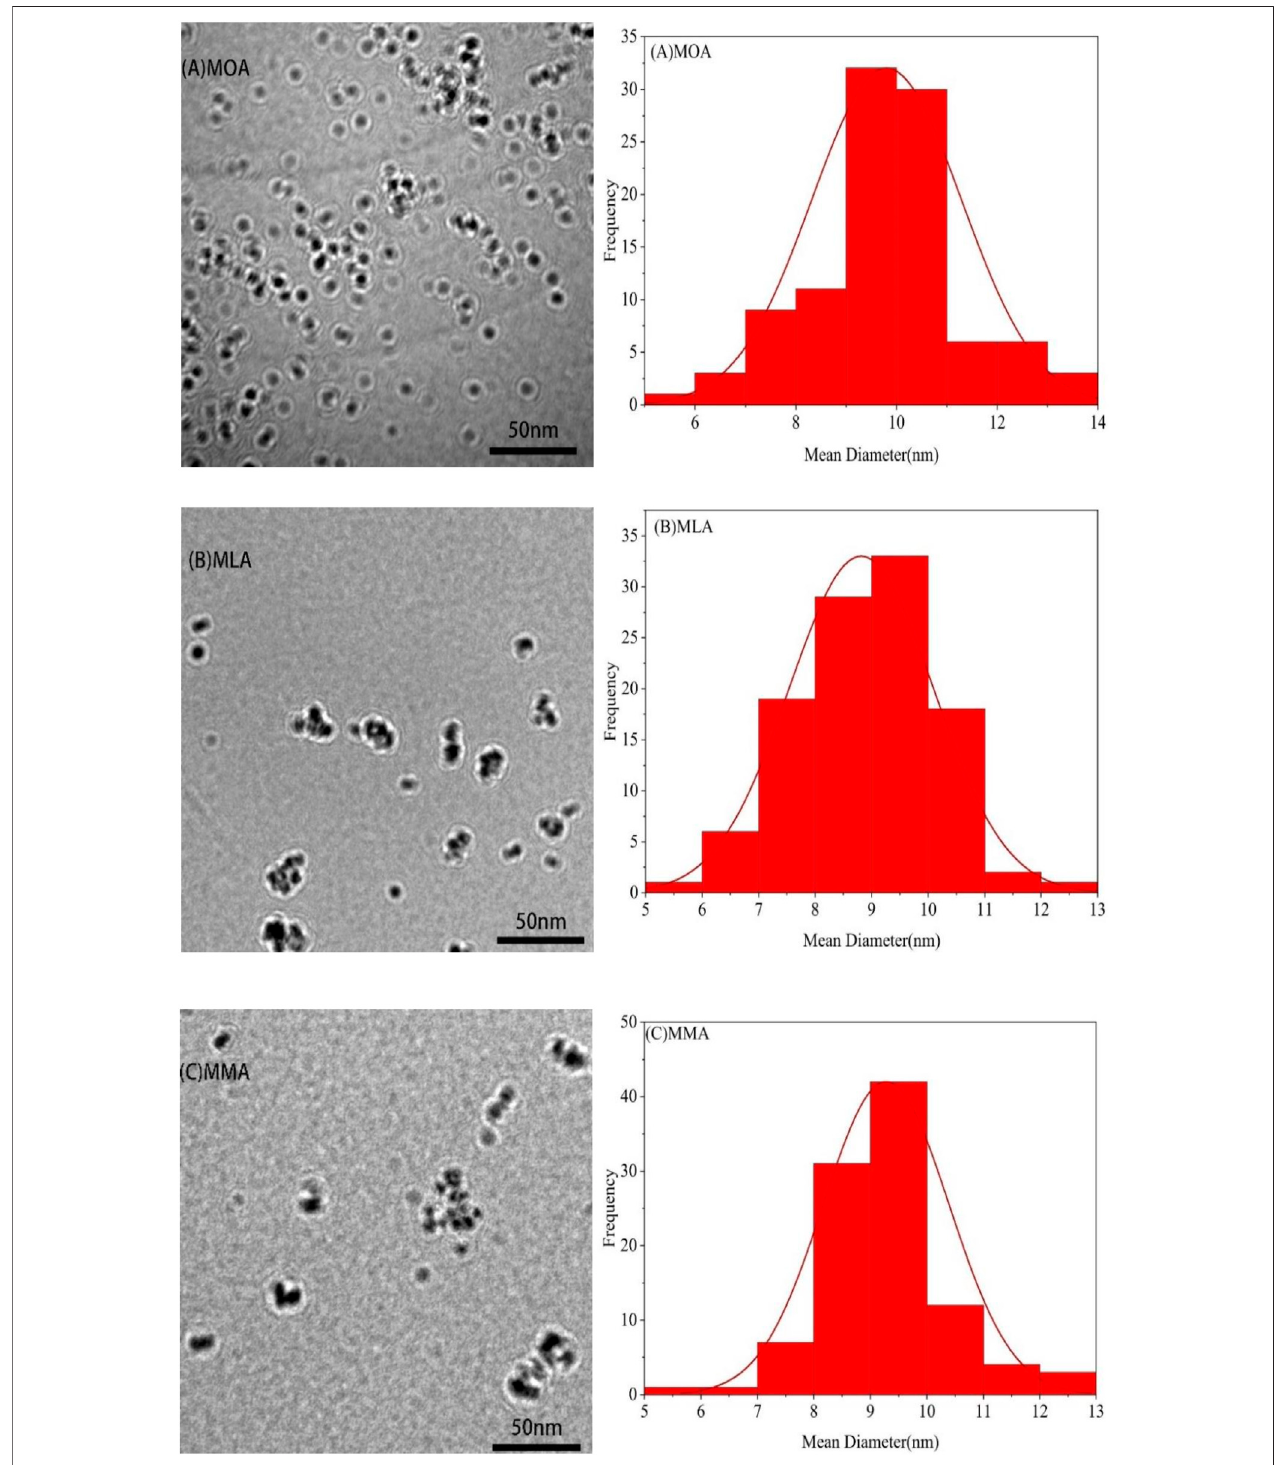
FIGURE 3 | TEM images of particles in three magnetic fl uids (left) and the corresponding particle size distribution histograms (right).